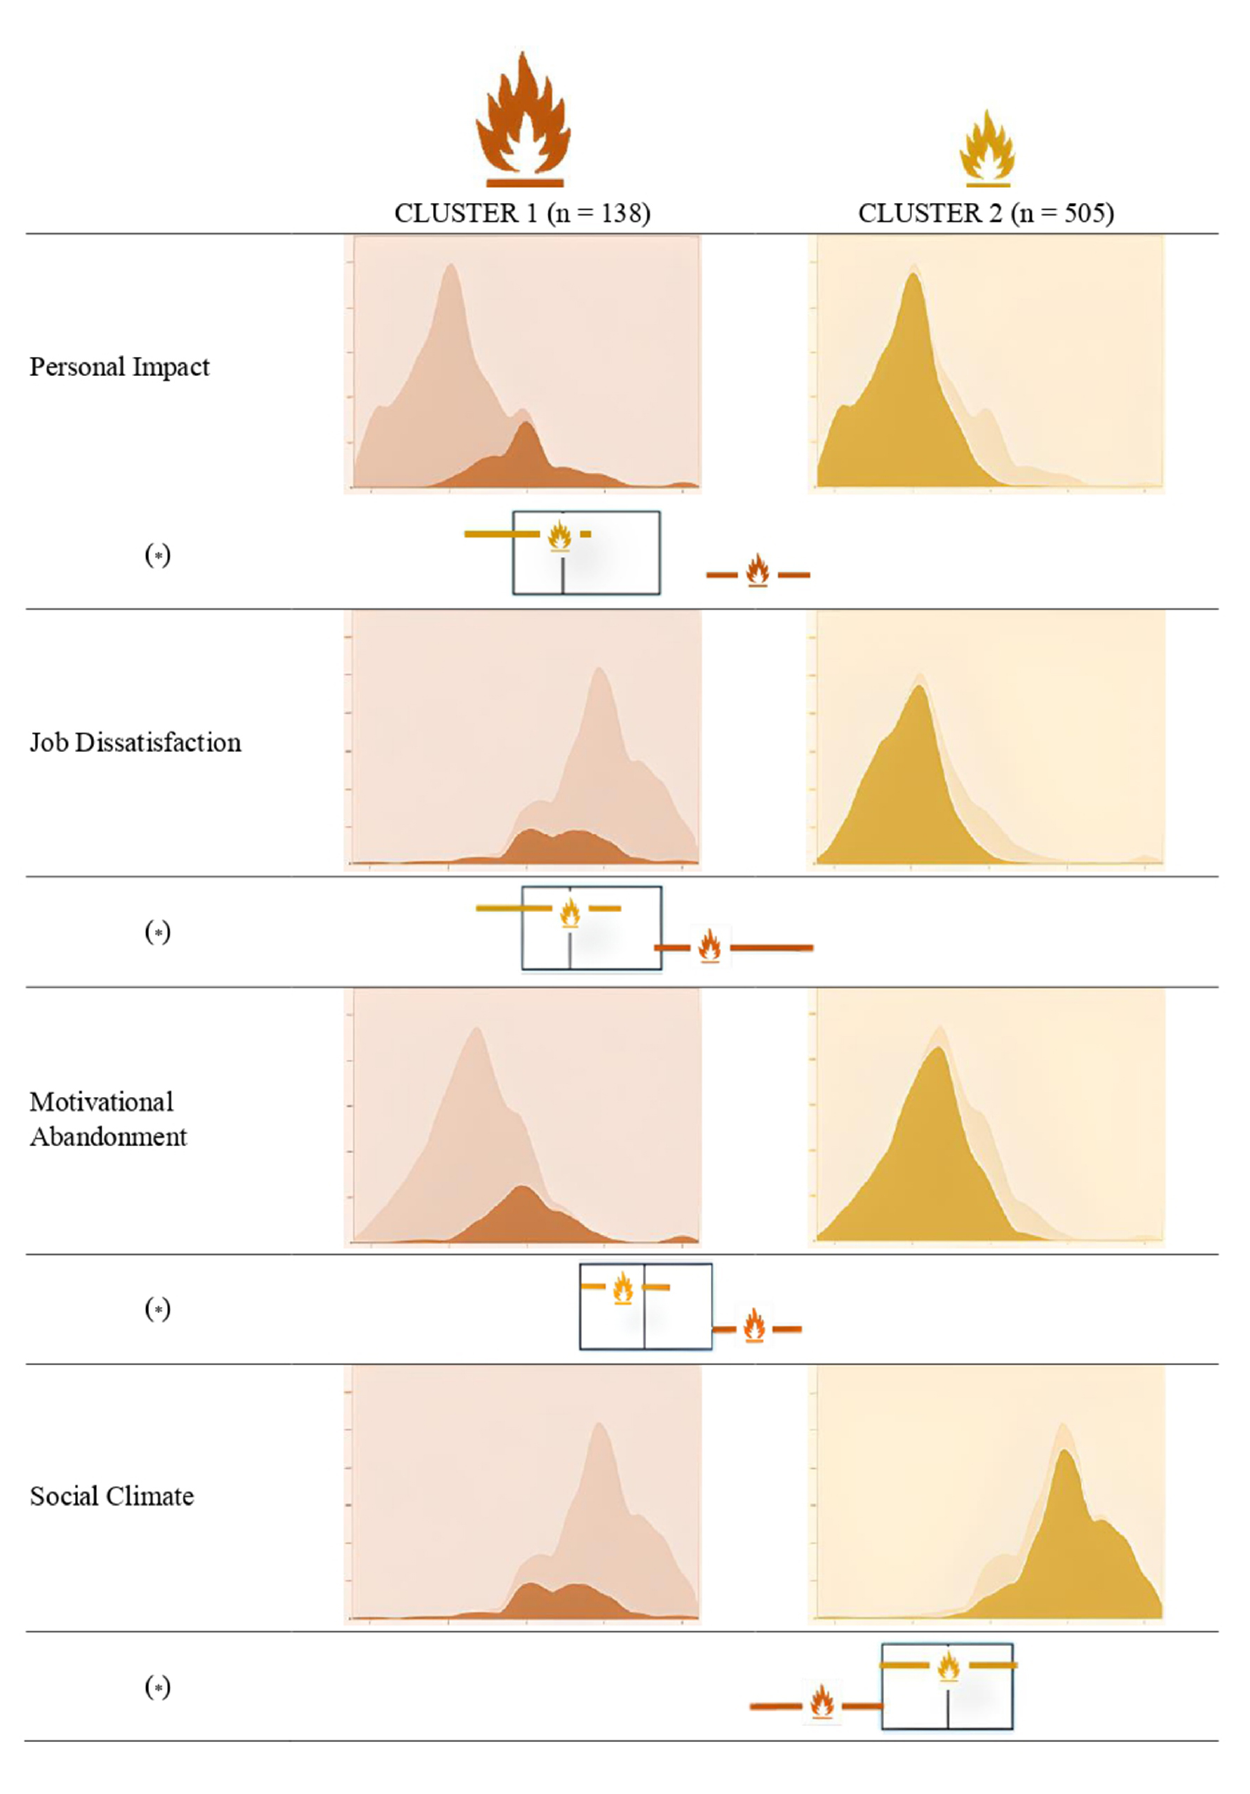
FIGURE 1. Cluster composition. Note. Factors in order of importance of input. (*) Cluster